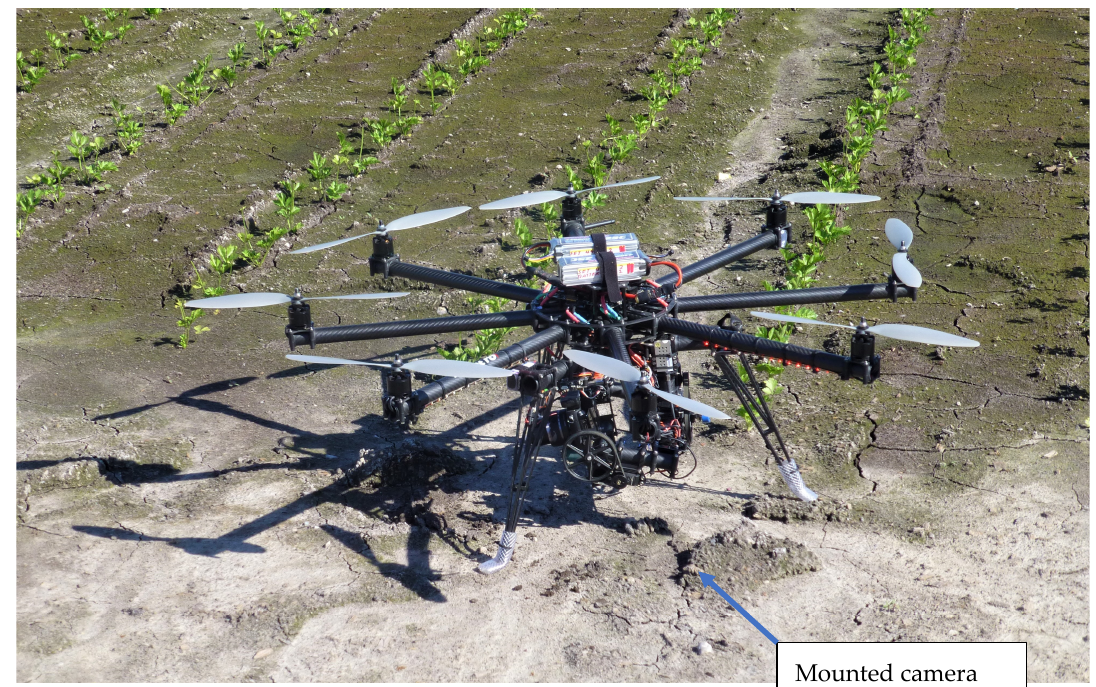
Figure 2. A modified Cine Star—8 MK Heavy Lift RTF octocopter mounted with a camera for aerial image collection at the Holland Marsh, Ontario in July 2015. Table 1. Descriptions of the four vegetative indices calculated from aerial images of onion field trials at the Muck Crops Research Station, Holland Marsh, ON in 2015 and 2016.